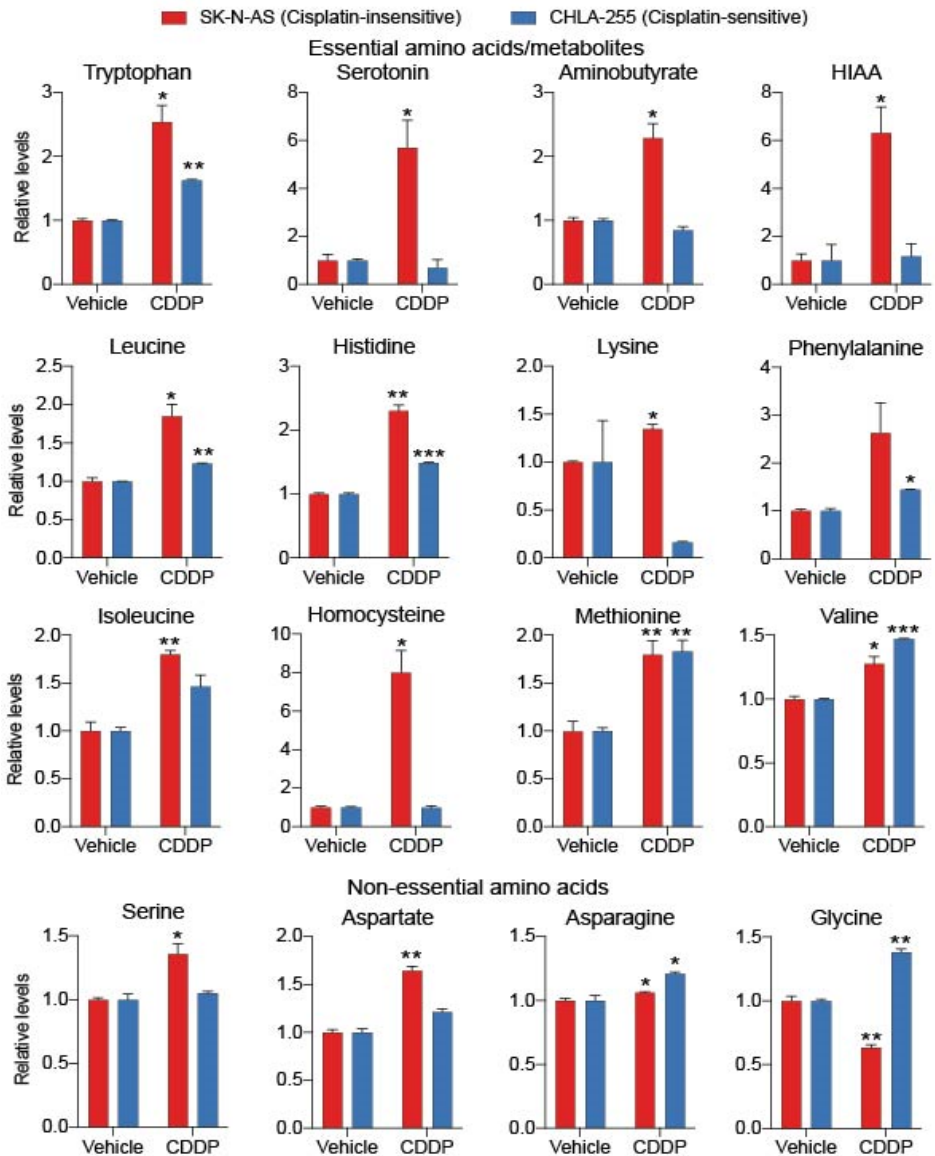
Figure 3. Amino acid metabolism was upregulated in cisplatin-insensitive neuroblastoma cells. Bar graphs showing relative quantification of amino acid levels in vehicle and cisplatin-treated insensitive SK-N-AS and sensitive CHLA-255 cells. Each bar represents mean ± SE of data obtained from three biological replicates. *, ** and *** indicate p < 0.05, p < 0.01 and p < 0.001, respectively, which were obtained through Student’s t -test by comparing the relative metabolite of the treated cell line with its respective vehicle, control